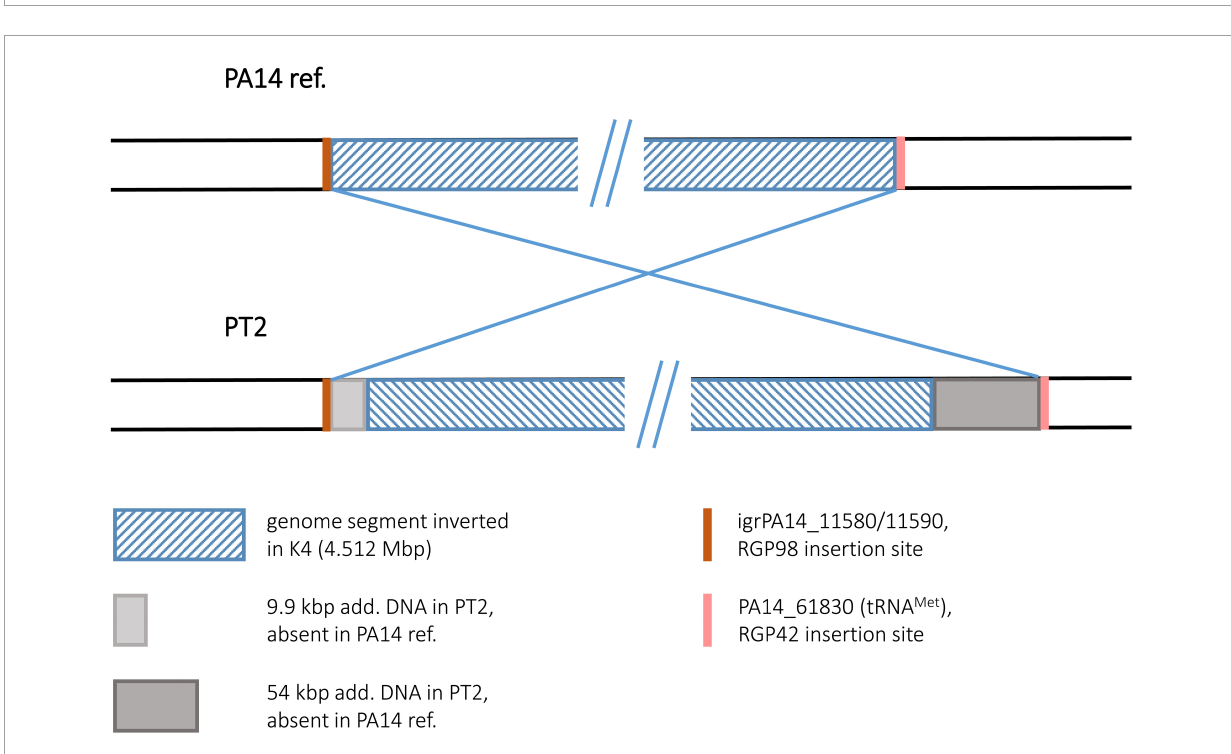
FIGURE11 Genomic inversion in strain PT2. This figure illustrates the genomic inversion detected in the PT2 sequence. The same inversion event was also detected in strain K4.